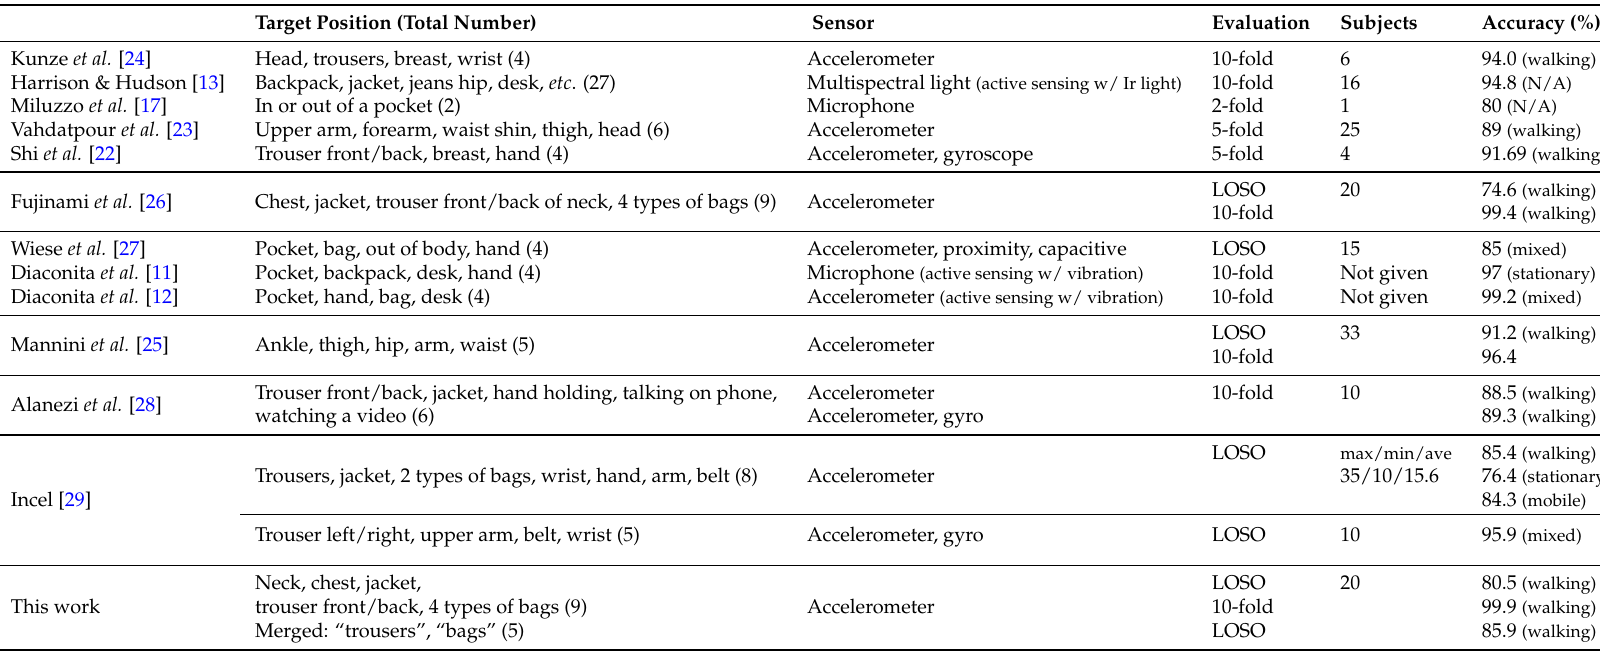
Table 1. Related work on on-body localization of a device. The brackets in the accuracy column indicate the condition of the evaluation. LOSO,